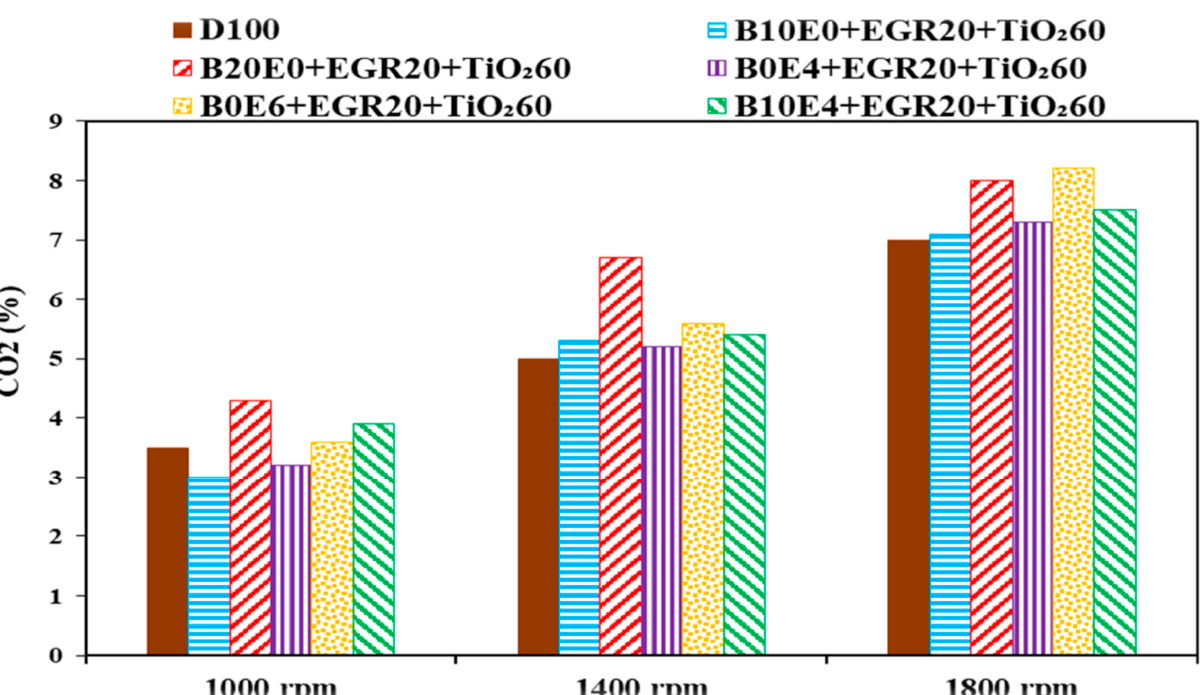
Figure 15. Variation of CO 2 for diesel/ethanol/biodiesel blends at EGR = 20%, TiO 2 = 60 ppm, and various engine speeds.